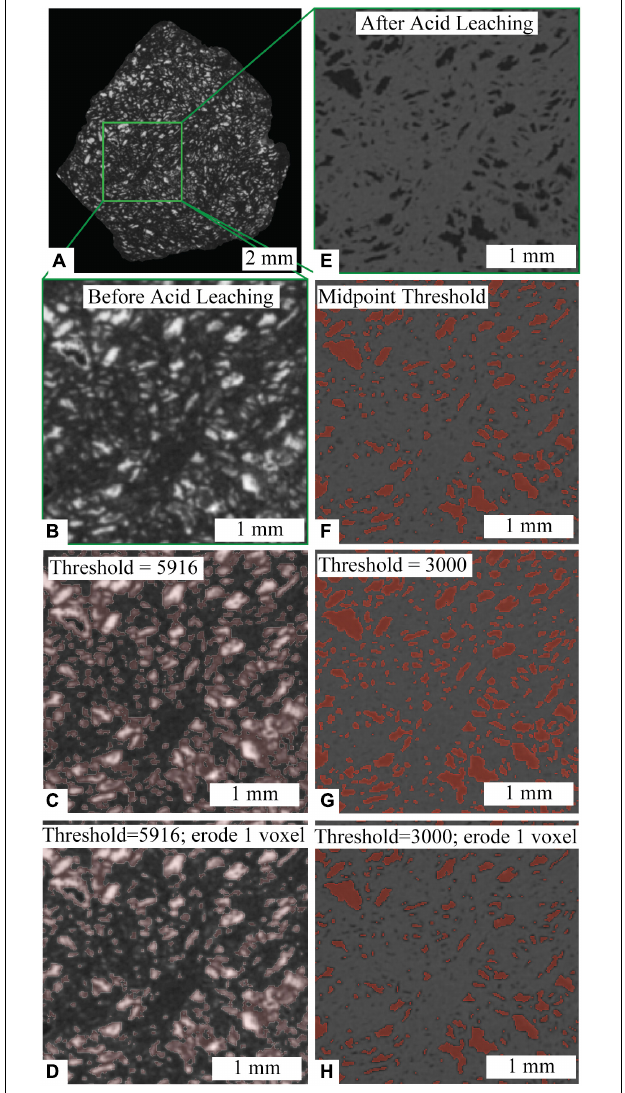
FIGURE 4 | (A) XCT slice of sample A before acid leaching with (B) zoomed in area and (C,D) segmentation attempts (outlined in semi-transparent pink). (E) Same zoomed in area after acid leaching procedure with (F–H) segmentation attempts (filled in semi-transparent red).